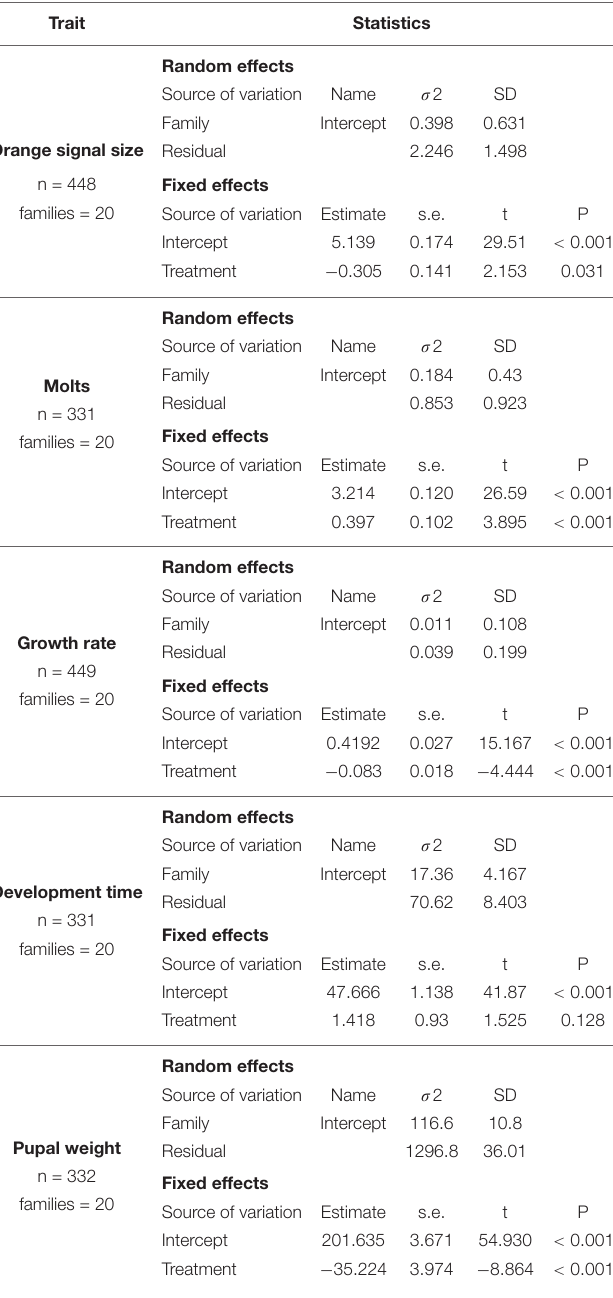
TABLE 1 | Full summary statistics for the influence of fixed effect, predation, random effect [family (all traits) and its interaction with predation (family-by- treatment)] effects on the warning signal and larval-history traits of A. plantaginis